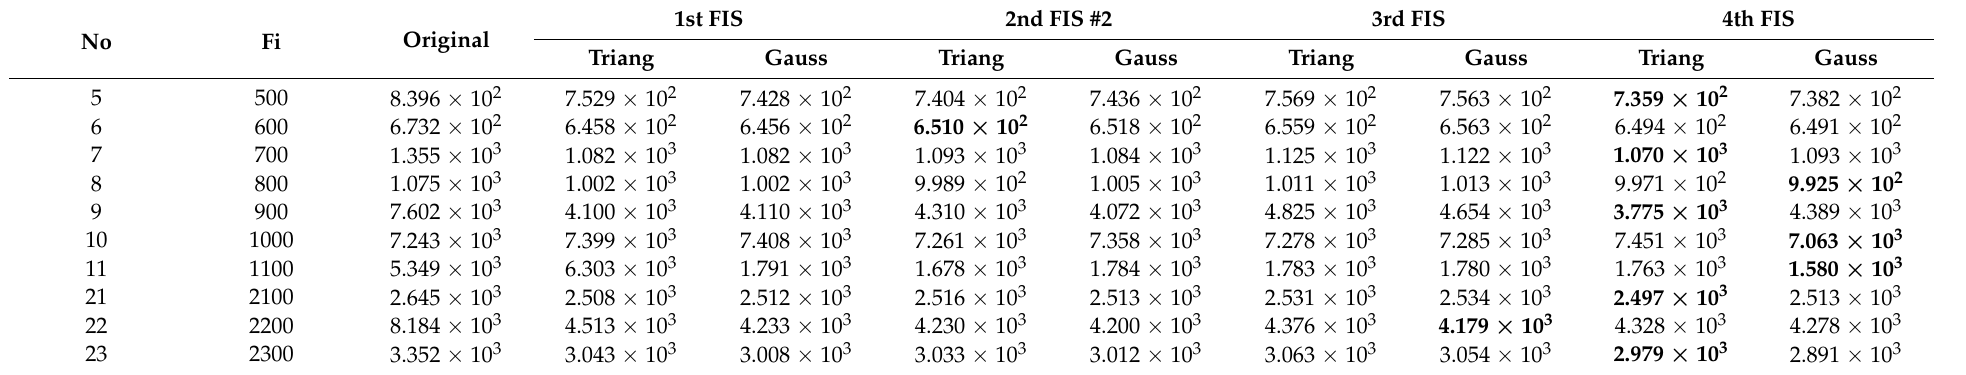
Table 4. Result of DBSA using type-1 fuzzy systems in CEC2017 functions.